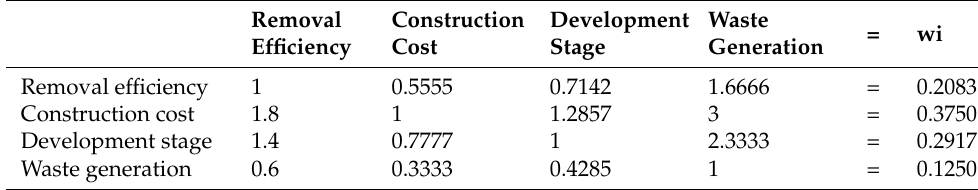
Table 2. Pairwise Comparison Matrix and WLC